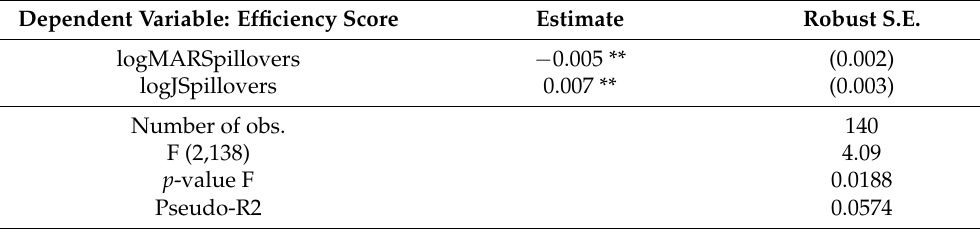
Table 5. Tobit regression: all countries 2002–2016 (average marginal effects). Dependent Variable: Efficiency Score